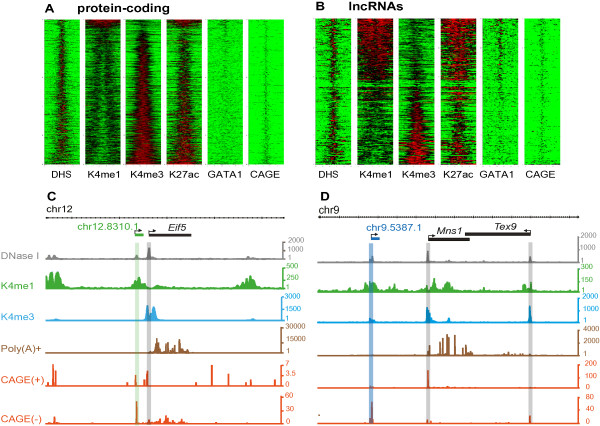
Contrasting epigenetic landscapes at transcriptional start sites for protein-coding genes and lncRNAs in mouse intermediate erythroblasts. The heatmap represents the distribution of DNAse I hypersensitive sites (DHS), H3K4me1, H3K4me3, H3K27ac, Gata1 and NanoCAGE signal (red high, green low) in a 4 kbp window centered around the middle of the nanoCAGE-defined TIRs for (A) protein-coding genes and (B) lncRNA loci. Representative novel (C) elncRNA (green, chr12:112754628 to 112804627 (mm9)) and (D) plncRNA (blue, chr9:72229000 to 72364999 (mm9)) were annotated de novo from C57BL/6 erythroid cell poly(A) + RNA (brown). Their transcriptional start sites were defined using strand-specific nanoCAGE (red; plus and minus signs represent density of reads within strand-specific libraries) found within DHS regions (grey). H3K4me1, green; H3K4me3, blue. Arrows on elncRNA and plncRNA and their neighboring transcript indicate the direction of transcription.